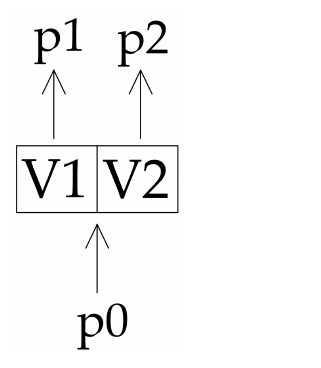
Figure 3. Two-section divider, different section